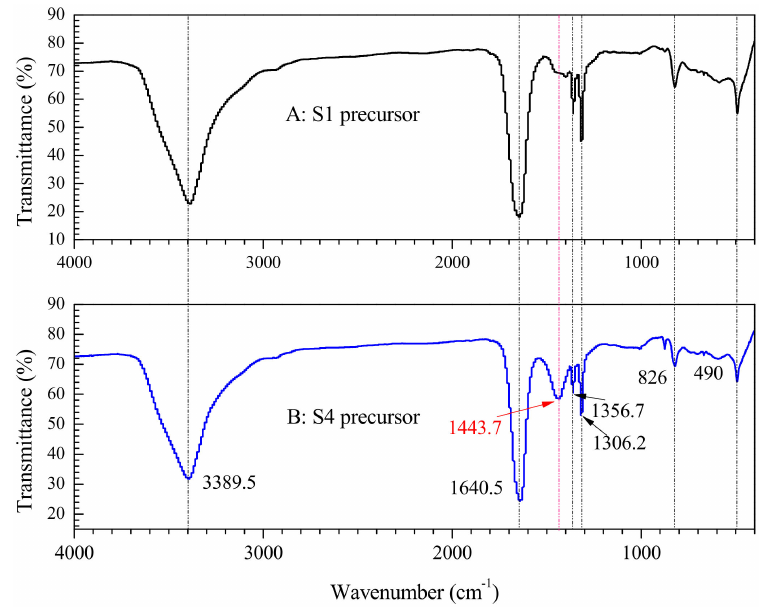
Figure 4. FTIR of dried S1 ceramic precursor ( A ) and dried S4 ceramic precursor ( B ).